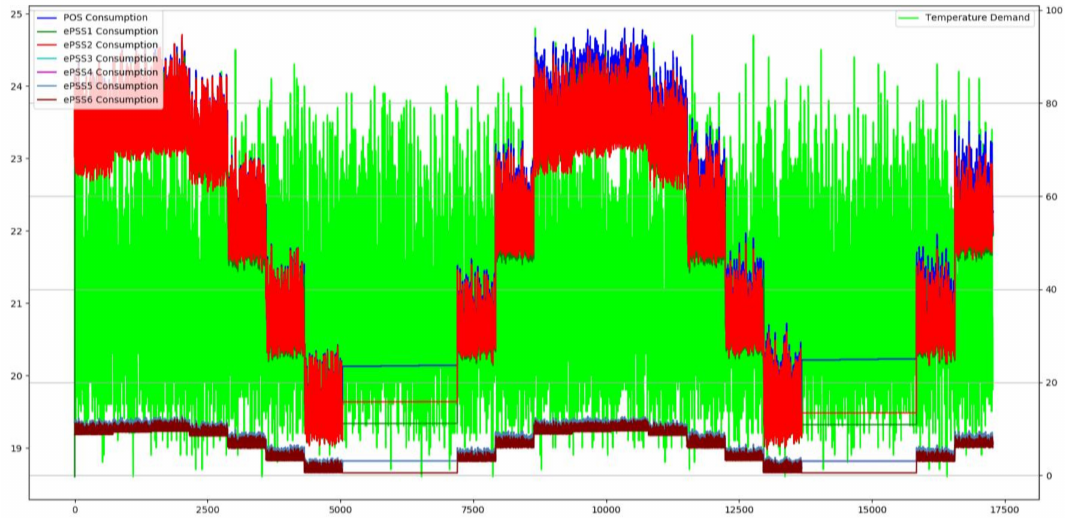
Figure 15. Comparison of Electricity Consumption for